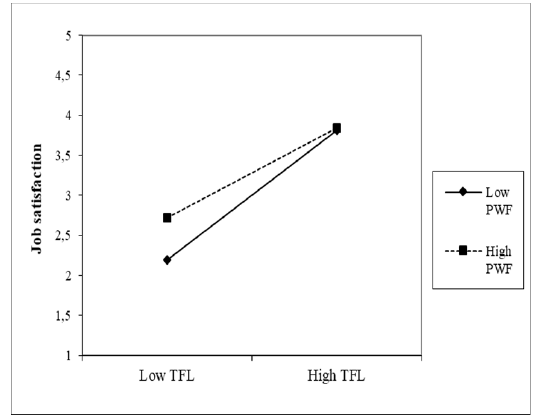
Figure 7. Moderating effect of PWF on the TFL-JS relationship.